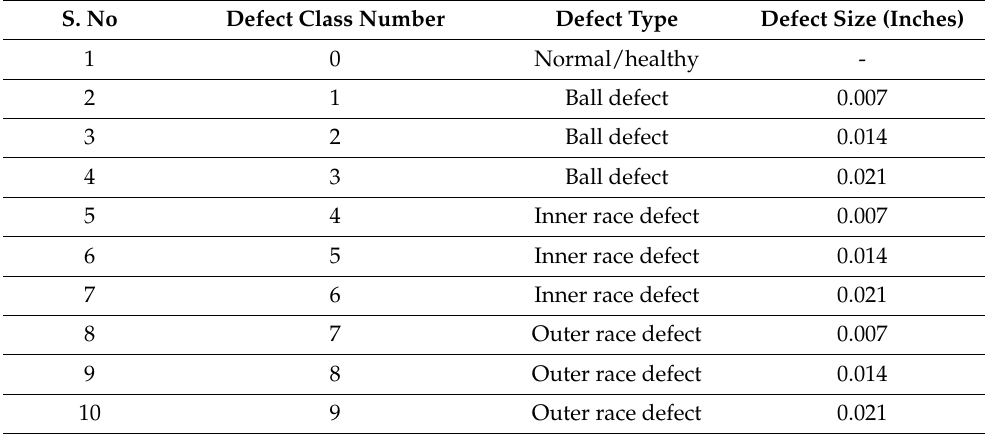
Table 2. Selected bearing fault